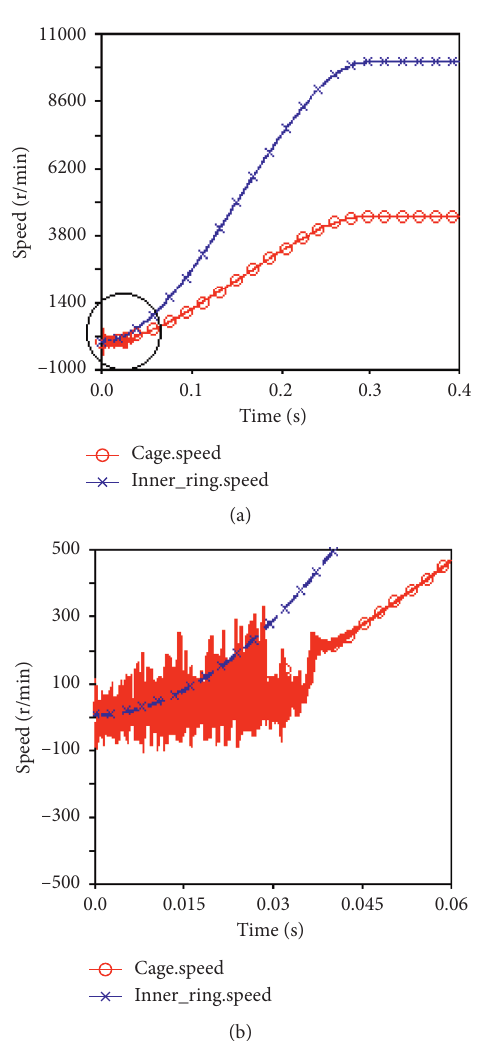
Figure 4: Speeds of inner ring and cage at the stage of start-up.